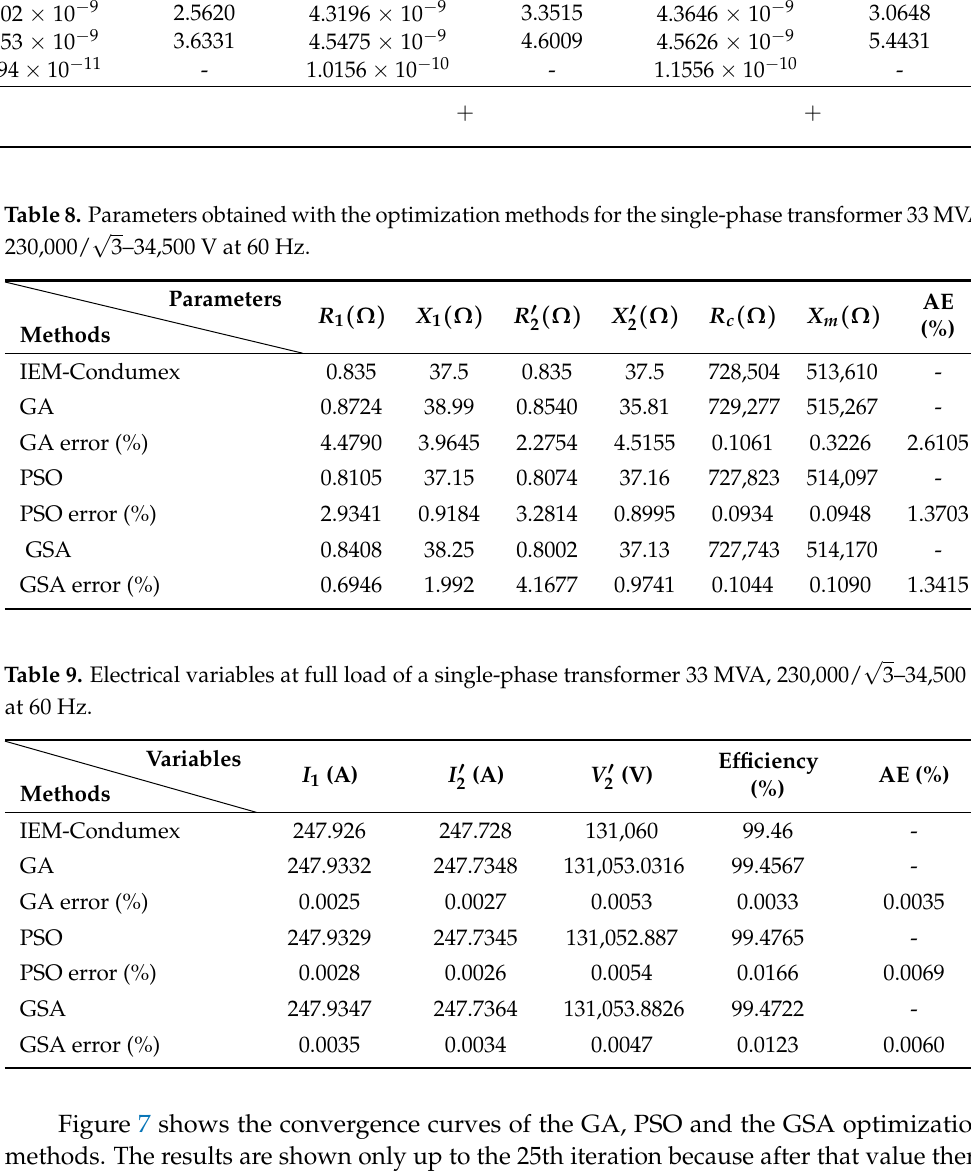
Table 7. Statistical values of the SPTECPs using the optimization methods for the single-phase √ transforme 33 MVA, 230,000/ 3–34,500 V at 60 Hz.